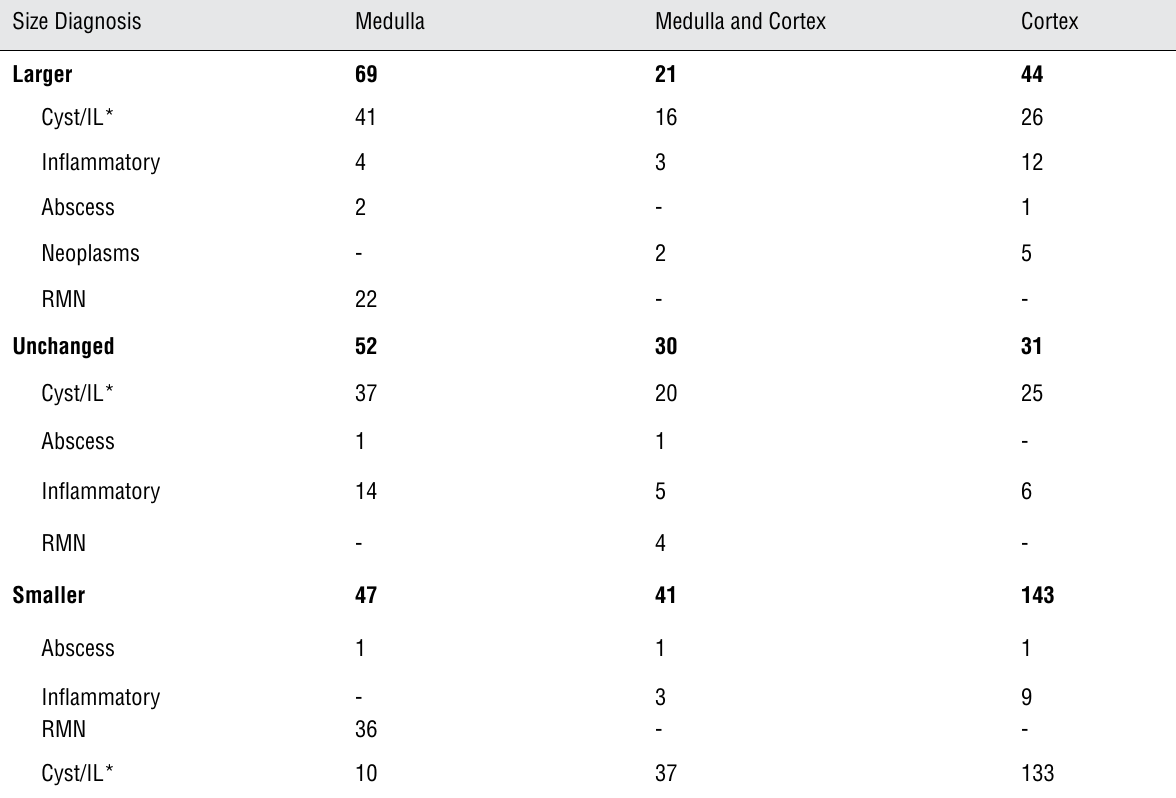
Table 3 - Outcome of 247 Enlarging or unchanged In size small Renal Masses Reexamined by Multiphase MDCT. Size Diagnosis Medulla Medulla and Cortex Cortex